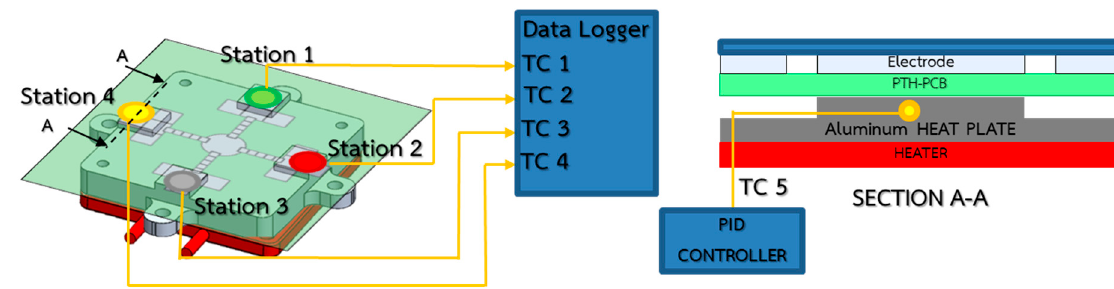
Figure 11. Installation of temperature control elements.